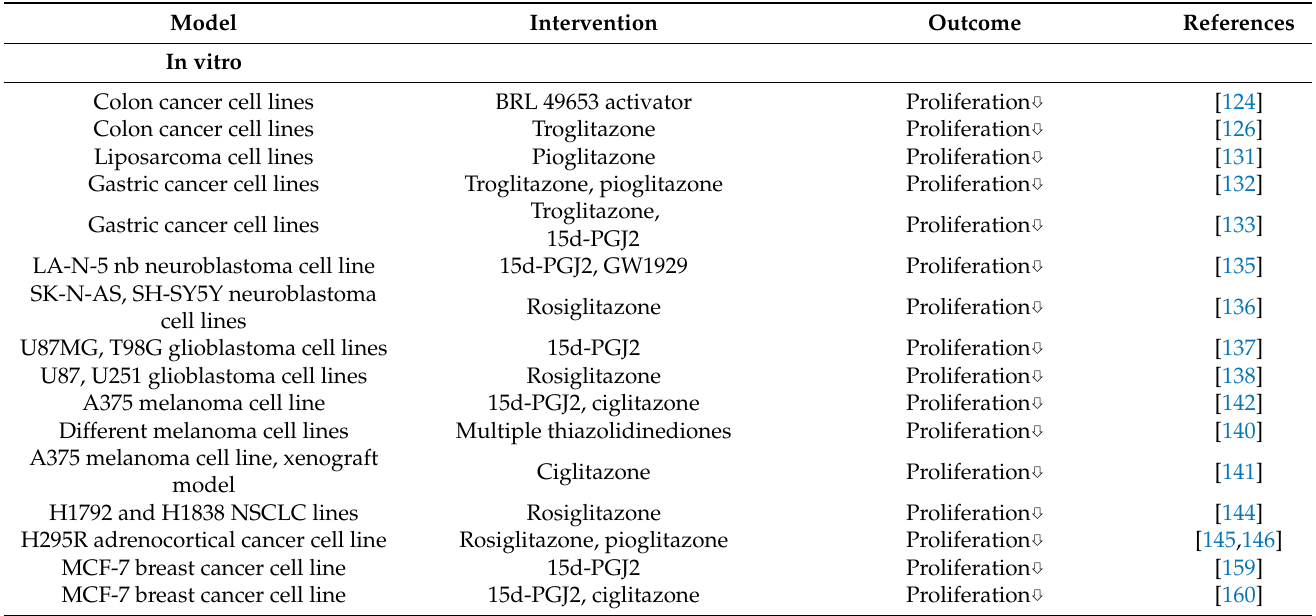
Table 1. Effects of PPARα on cell proliferation and tumor growth.